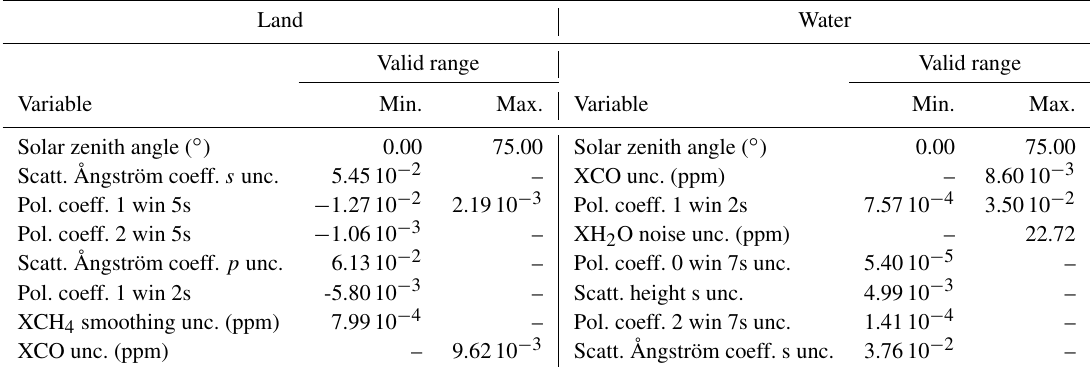
Table A11. XCO filter variables and limits for GOSAT-2. “–” means that no limit is applied. Except for the solar zenith angle limits, the variables are ordered by their relevance, i.e. by the number of data filtered out.